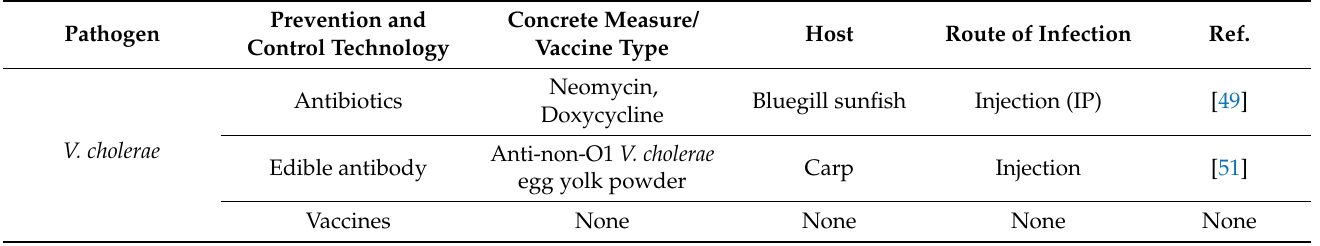
Table 4. Control and prevention strategies of V. cholerae. NR: Not Relevant, None: the method has not been tested in vivo or relevant data has not been